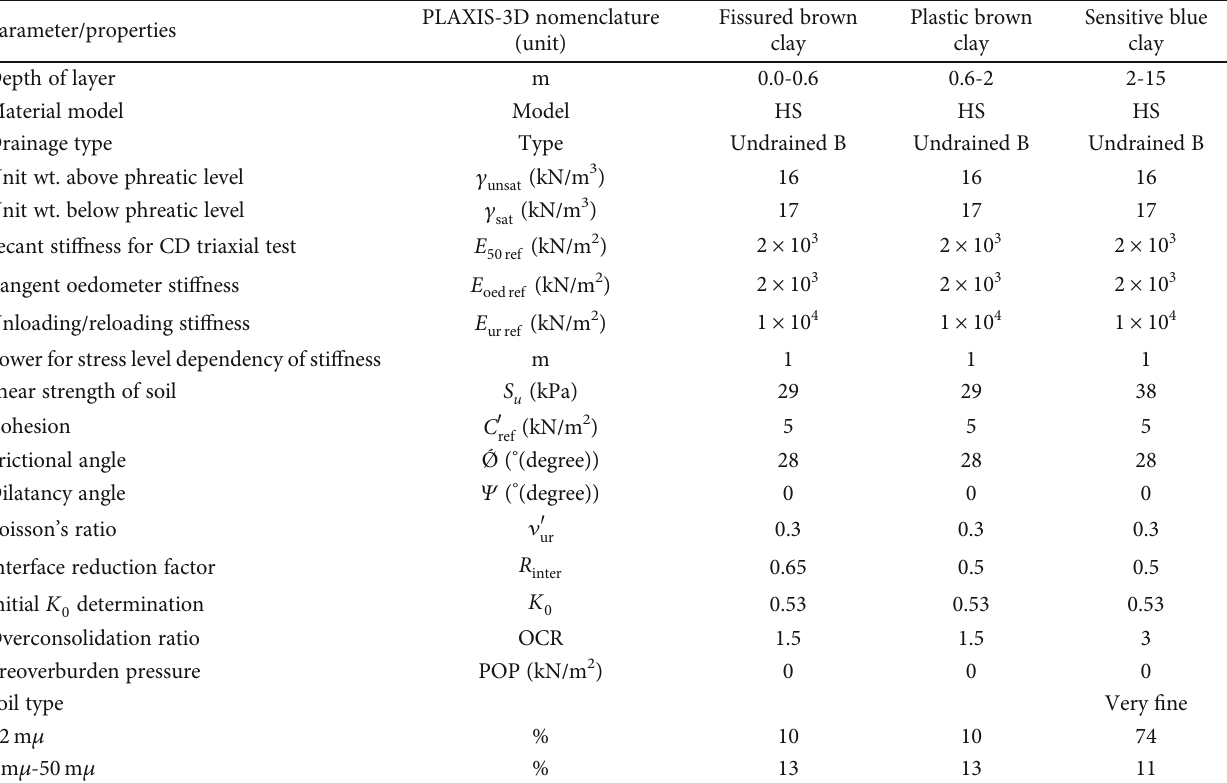
Table 10: Properties of Louiseville soil and hardening soil (HS) material model parameters used for FE modelling.